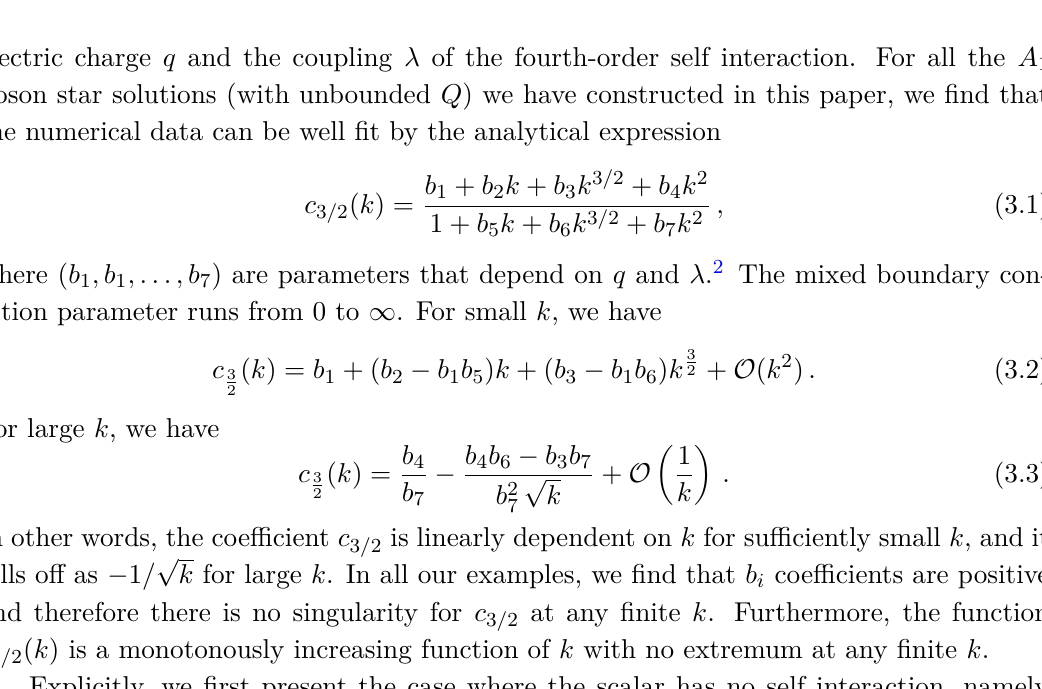
Table 1 . The list of b i coefficients of the function c